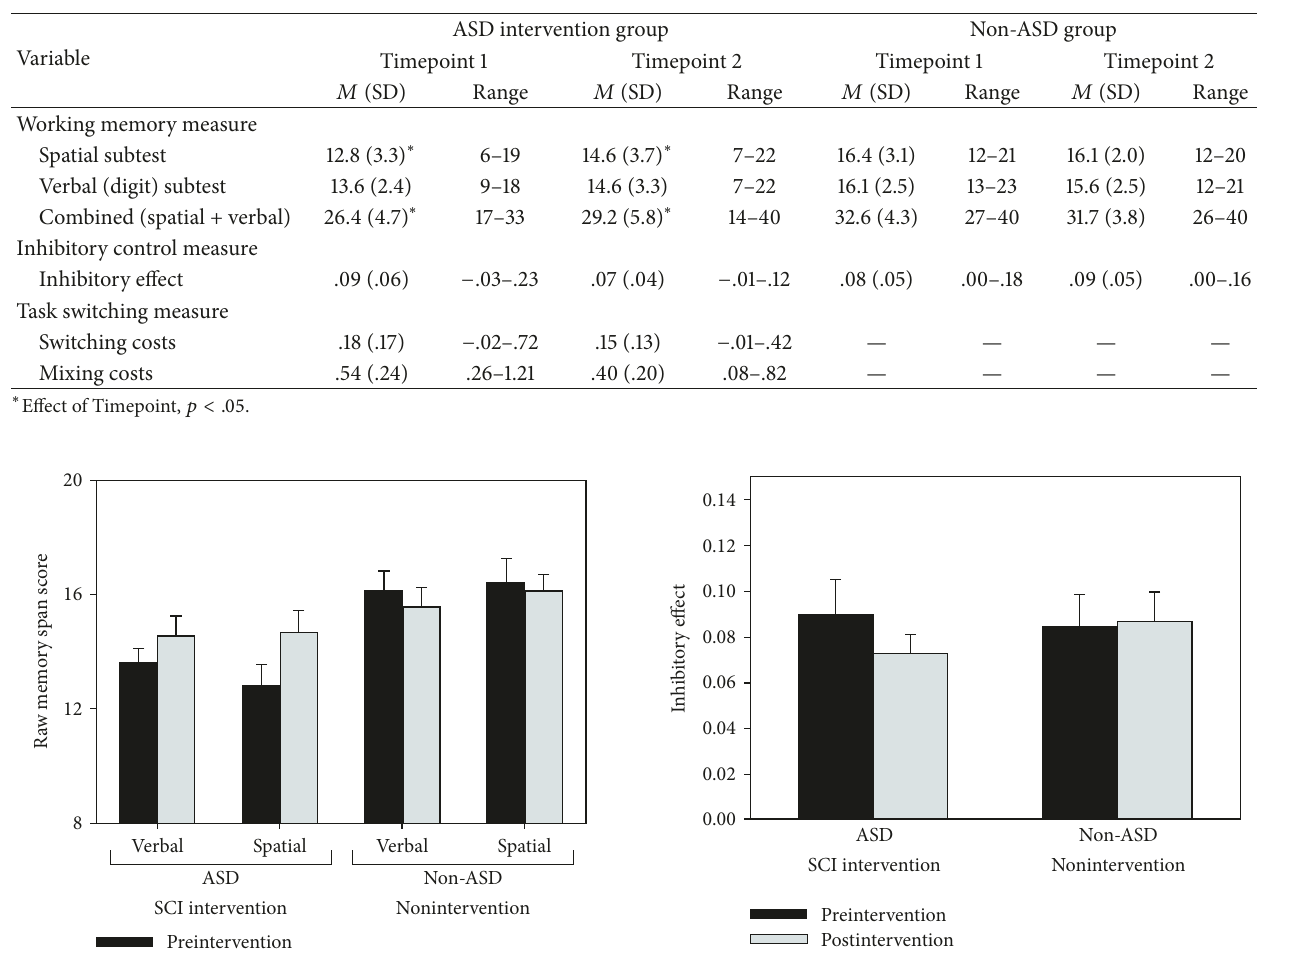
Table 3: Descriptive statistics for performance on each task.